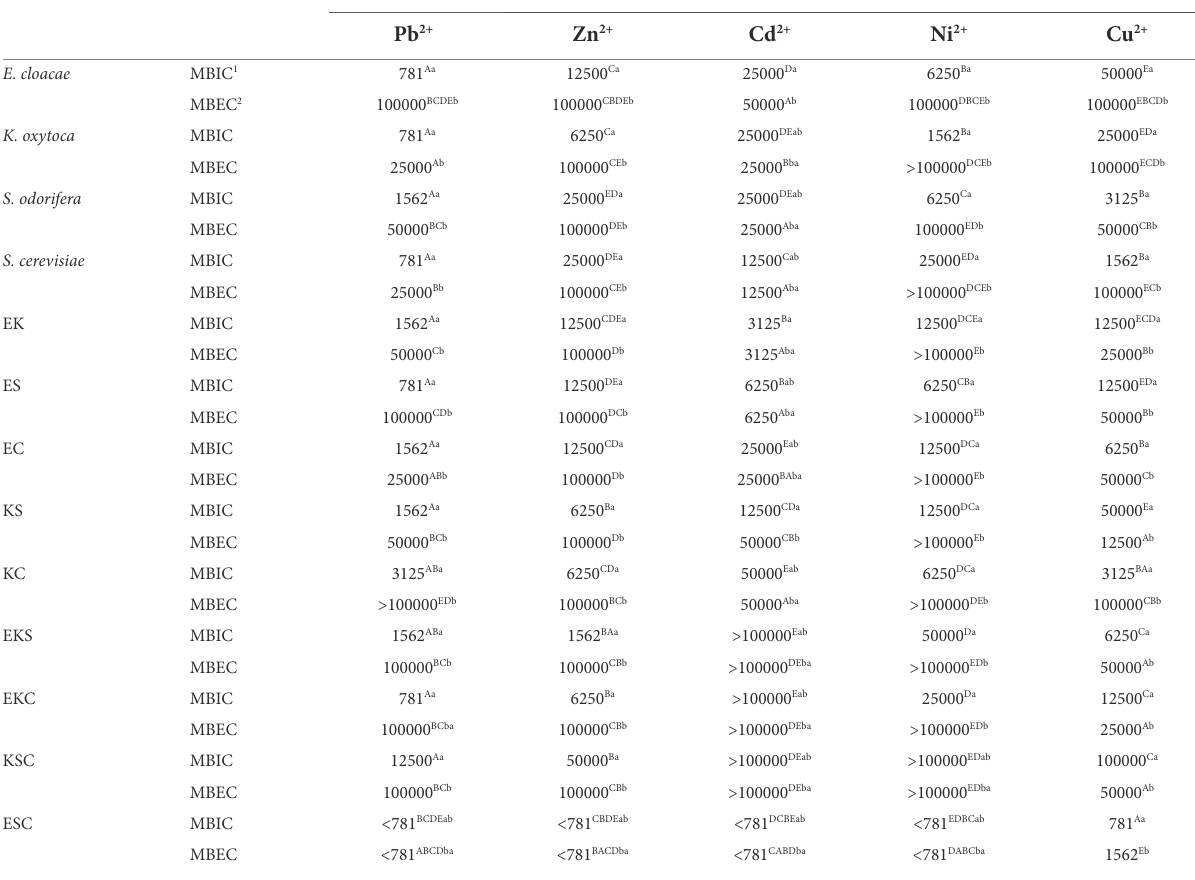
TABLE 3 Degree of resistance for single-and mixed biofilms in the presence of selected HMs. Microbial cultures